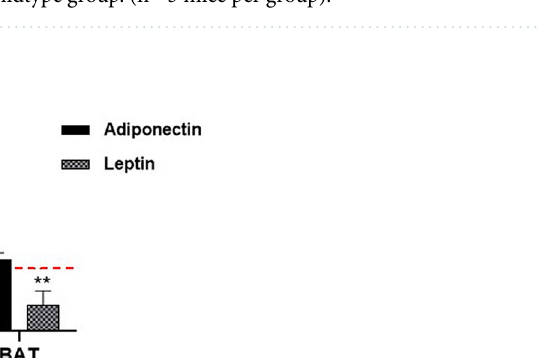
Figure 6. Effect of NAG-1 on the mRNA expression level of insulin signaling pathway-related factors. ( A ) RT-PCR of NAG-1 gene expression in the muscle, iWAT, and BAT. Ctrl indicates negative control. The mRNA expression levels of Irs1 , Glut4 , Pparg , Akt , Pi3k , Ptpn1 ( Pten ), Gsk3b , Foxo1 , Mtorc1 , Mtorc2 , and As160 in the ( B ) muscle tissue, ( C ) inguinal white adipose tissue, and ( D ) brown adipose tissue were examined using quantitative real-time polymerase chain reaction. The thermogenesis related mRNA level of Ucp1, Cidea, Prdm16, Dio2 and Fgf21 were also determined in BAT. The expression levels of target genes were normalized to those of Gapdh . Data were analyzed using the Student’s t -test and are presented as mean ± standard error of mean. *p < 0.05, **p < 0.01, and ***p < 0.001, compared with the wild-type group (n = 3). ( E ) Western blot data represent the protein expression of p-Akt (Ser473), total Akt, pIRS1 (Tyr612) and pro-NAG-1 in skeleton muscle of WT diabetic mice (WT) and NAG-1 Tg diabetic mice (TG). The graph represents the relative protein expression. *p < 0.05, compared with the wildtype group. (n = 3 mice per group).